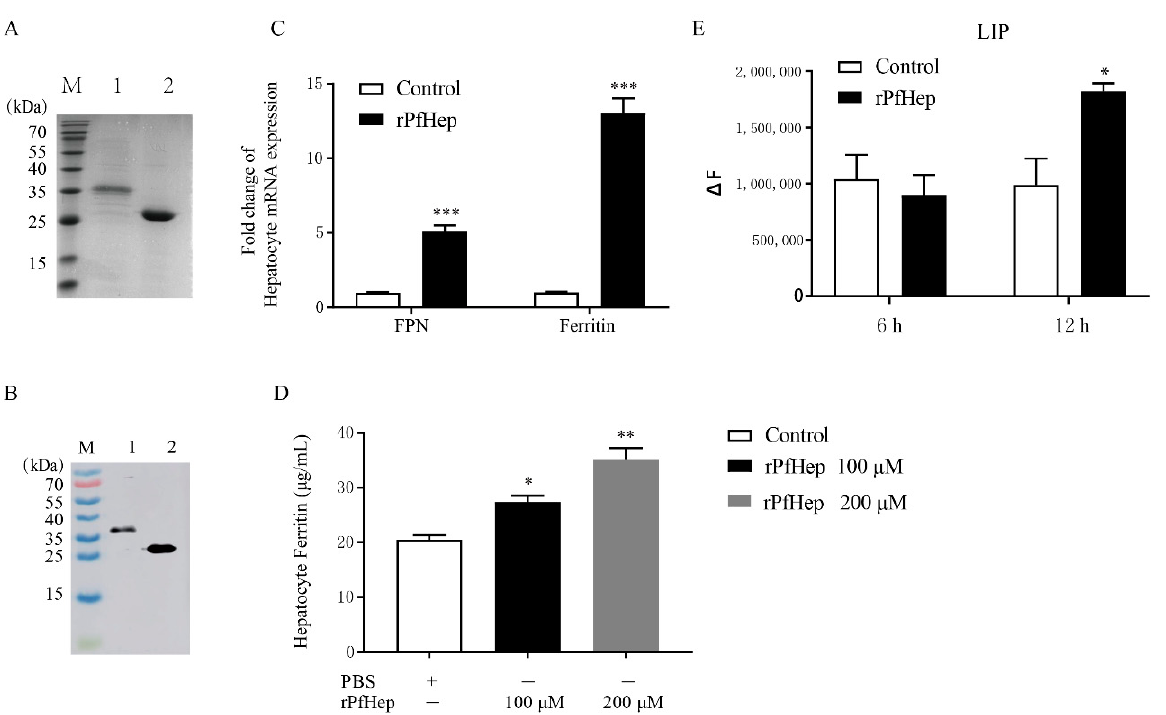
Figure 1. rPfHep is a protein regulating iron level. ( A ) SDS-PAGE analysis of purified pGEX-KG-hepcidin. M, markers; lane 1, pGEX-KG-hepcidin, lane 2, GST protein. ( B ) Western blotting assay of anti-GST antibody. M, markers; lane 1, pGEX-KG-hepcidin fusion protein with GST; lane 2, GST protein. ( C ) qRT-PCR assay of mRNA level of Ferritin and FPN (Ferroportin) in hepatocytes treated with rPfHep. ( D ) ELISA of Ferritin level in rPfHep-treated hepatocytes (100 µ M and 200 µ M). ( E ) Fluorescence assay of LIP level in hepatocytes treated with rPfHep. * p < 0.05; ** p < 0.01; *** p < 0.001 versus control.